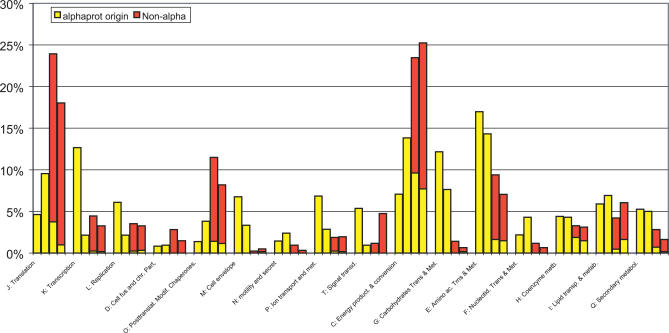
Relative Weights of the Functional Classes in the ProteomesFrom left to right, Mesorhizobium loti, the proto-mitochondrion, yeast mitochondria, and human mitochondria. The colors in the bars indicate the origin of the proteins in that functional class for that given organism (yellow: alpha-proteobacterial origin. red: other origin). We used the NJ-set as a reference to calculate the fraction that is evolutionary-derived from the proto-mitochondrion. Functional classes are derived from COG [16]. Alpha-proteobacterial–derived proteins are a minority in all classes except Coenzyme biosynthesis; the energy production/conversion class is the most “alpha-proteobacterial–derived.”